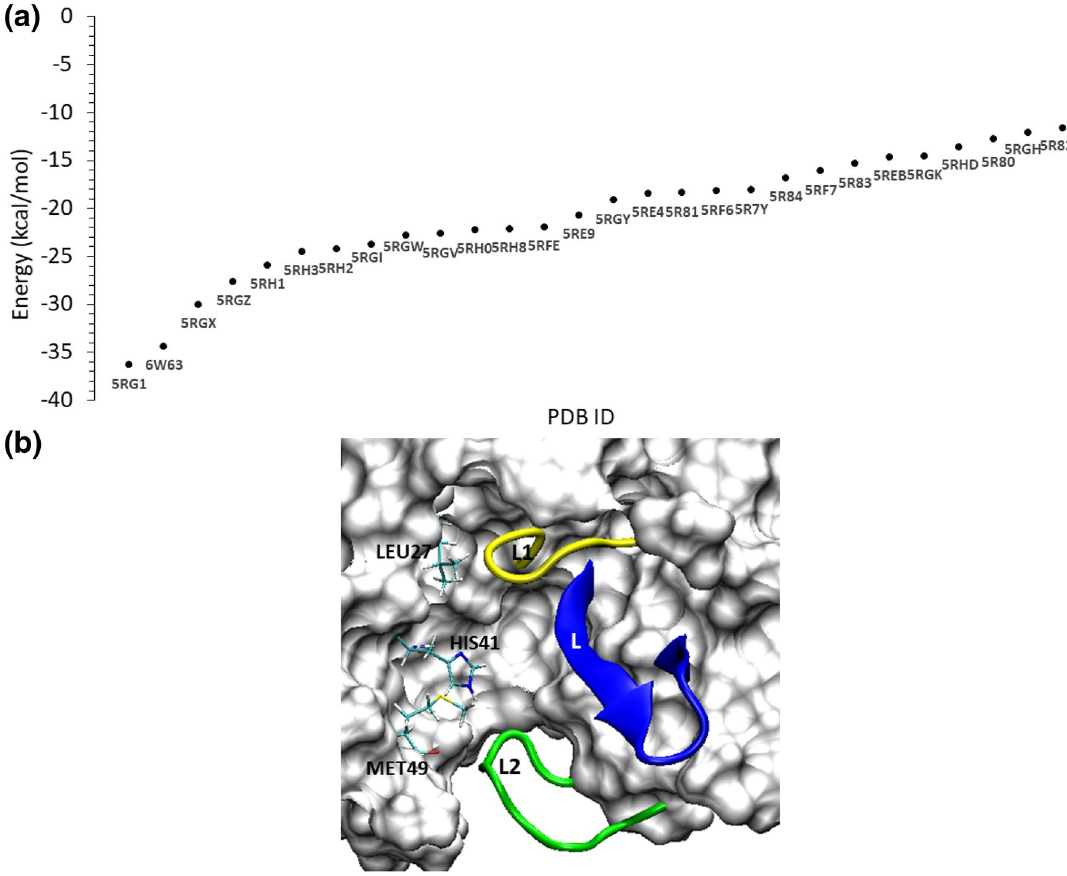
Figure 4. The scatter plot comparing the binding free energies of the ligand–M pro complexes in which the ligands were bound in catalytic site ( a ) and the identification of four key components that are critical for ligand- binding in this site ( b ). Two loops flank the active site pocket: the L1 loop shown in yellow, and the L2 loop (or the domain II-III linker loop) shown in green. In addition, the ‘L’ β-sheet is shown in blue, and the residues such as HIS41, LEU27, and MET49 located deep inside the pocket are shown as stick representation. The molecular graphic in this figure was generated using VMD 1.9.3 63 ( b ) while the scatter plot was generated using Microsoft Excel 365 ( a ) (https:// www. office.